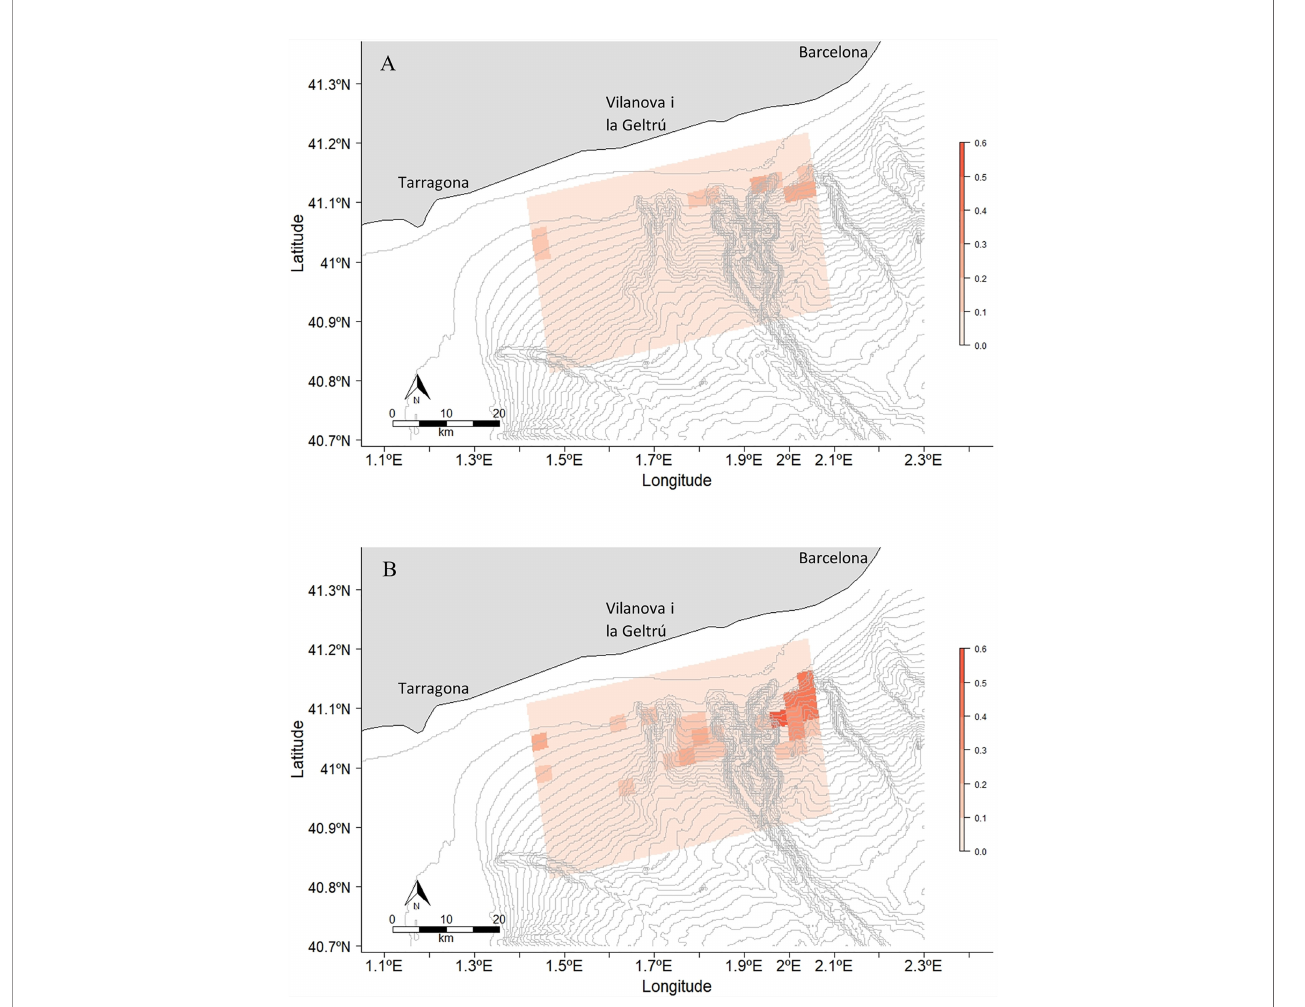
FIGURE 9 | Risk of collision between a fi n whale and a cargo ship in (A) March and (B) April. The risk range is between 0 and 0.6. April was the month with the highest risk. The other maps with the risk of collision with cargo ships in May, with tanker ships and with passenger ships can be found in the Supplementary Figures S32-S34